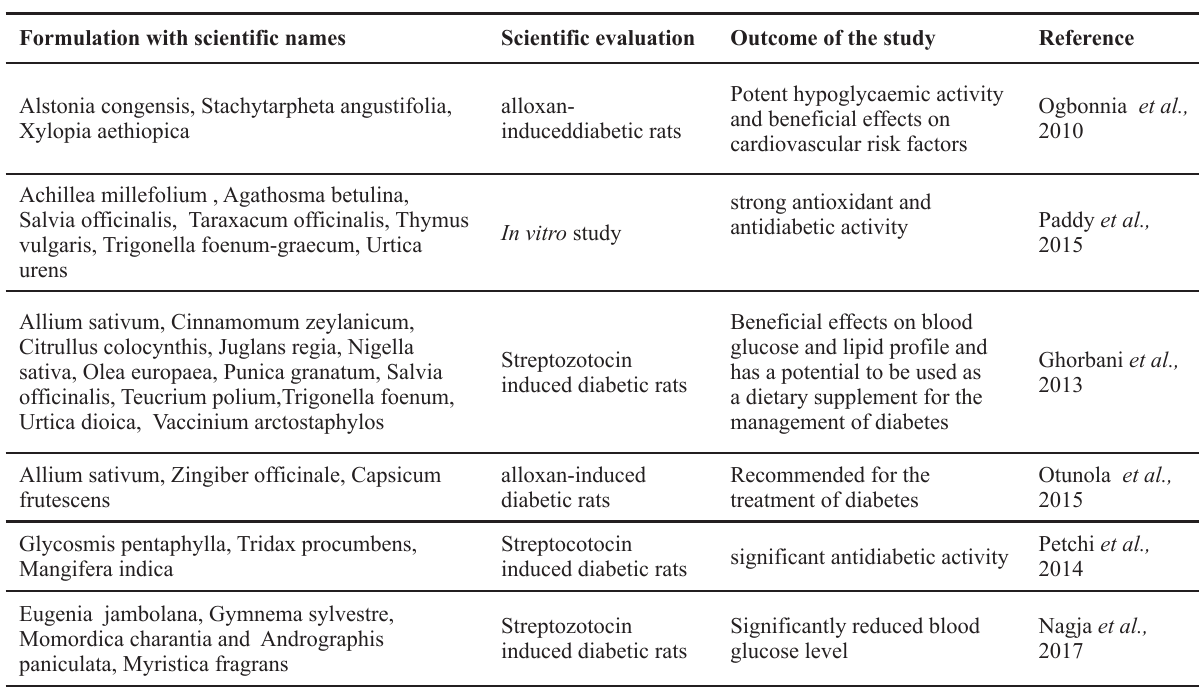
Table 3: A list of recently scrutinized polyherbal